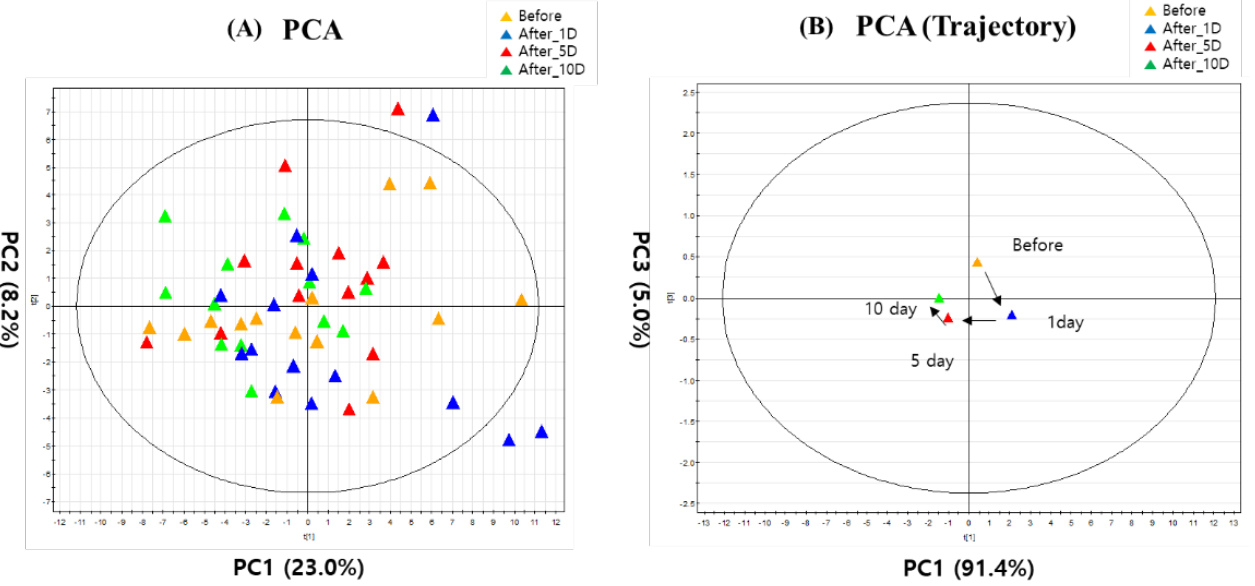
Figure 1. ( A ) PCA and ( B ) trajectory PCA score plots based on identified urinary metabolites. Before: